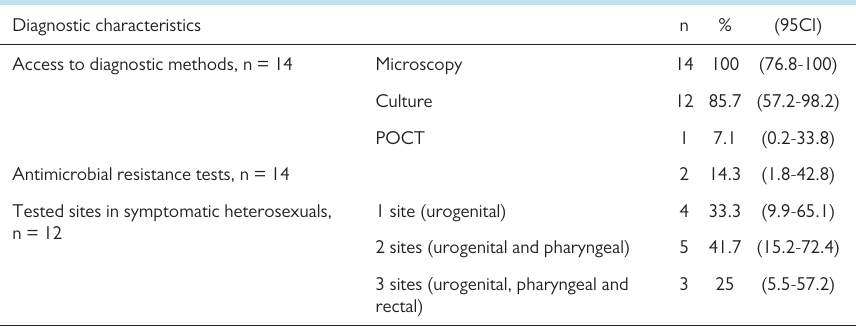
Table3. Diagnostic Management of Neisseria Gonorrhoeae Infections in Regional STI Clinics,